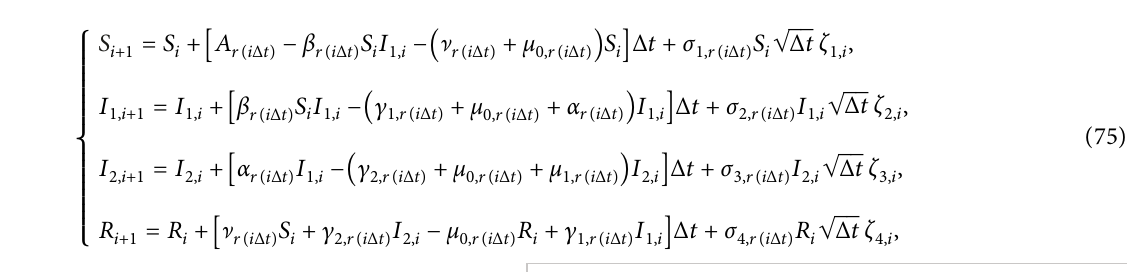
( t ) , I ( t ) , and R ( t ) for the stochastic systems 1 2